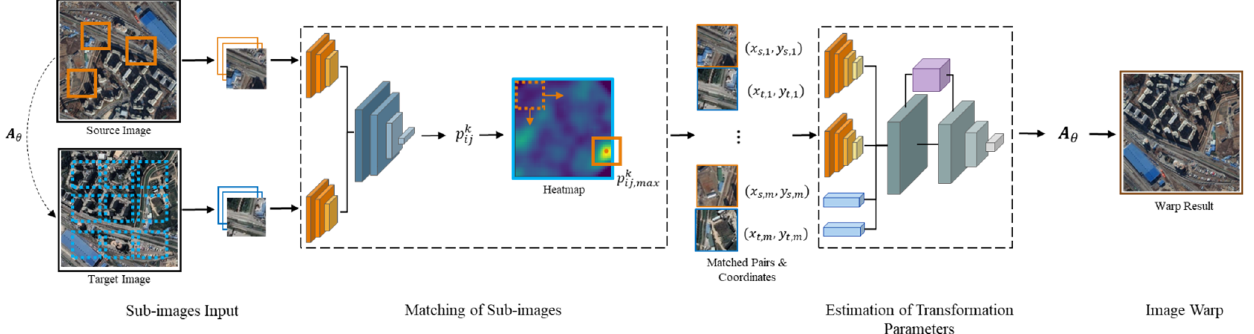
Figure 1. The pipeline of the proposed two-stage registration method. Matching of sub-images (MSI) and estimation of transformation parameters (ETP) in the dotted boxes are the main procedures. A θ is the affine transformation matrix from the source image to the target image. The orange boxes are the selected sub-images from the source image, and the blue boxes represent the sub-images which are searched from the target image to be matched with each source sub-images. p k ij represents the similarity between the k th sub-image from the source image and the sub-image located at ( i , j ) from the target image. The maximum of p k indicates the location of best-matched pair. ( x s , m , y s , m ) , ( x t , m , y t , m ) represent the coordinate of ij the m th pair of sub-images from the source and target sub-images,